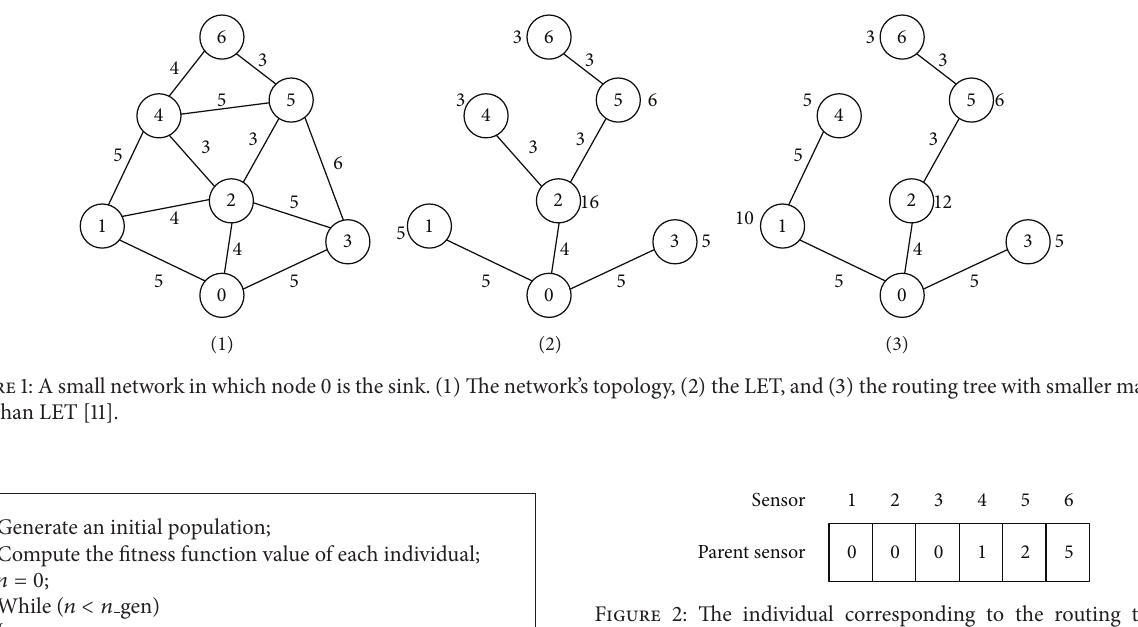
Figure 2: The individual corresponding to the routing tree in Figure 1 (3)